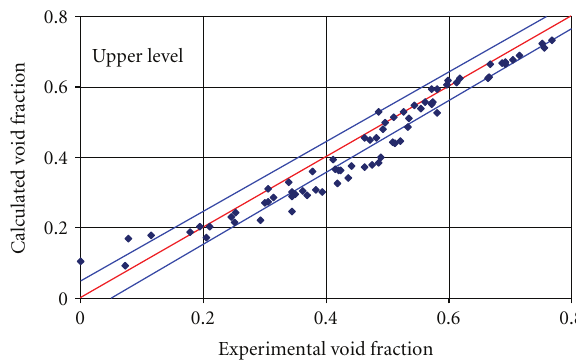
Figure 8: Comparison of calculated and measured void fraction for case B5 at the upper axial